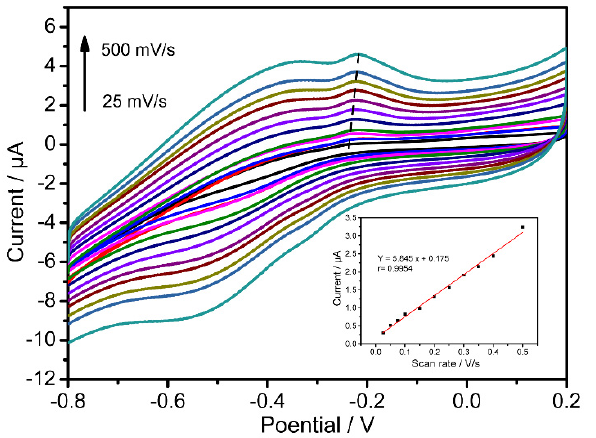
Figure 5. CV curves of PQT@GCA electrode at various scan rates from 25 mV/s to 0.5 V/s. The inset is the linear relationship between scan rate and oxidation peak current.